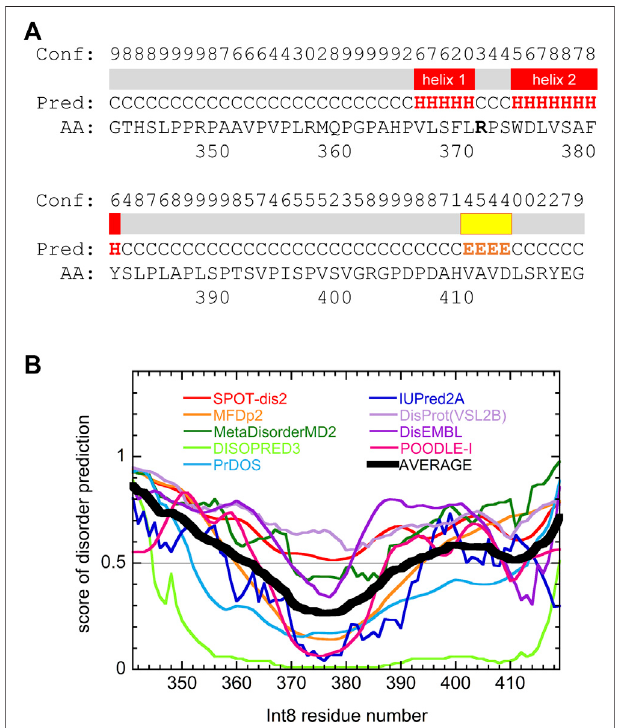
FIGURE 6 | Secondary structure and disorder predictions of wild-type Int8. (A) Secondary structure prediction by PSIPRED. Pred indicates the predictedsecondary structure(H, α -helix;E, β -sheet;andC,coil).Confshows the con fi dence level of the prediction. Regions predicted to form α - helices and β -sheets are shown by red and yellow boxes, respectively. (B) Disorder prediction by nine different prediction servers. Black thick line shows the average of the predictions. Regions with a score larger than 0.5 are predicted to be disordered.